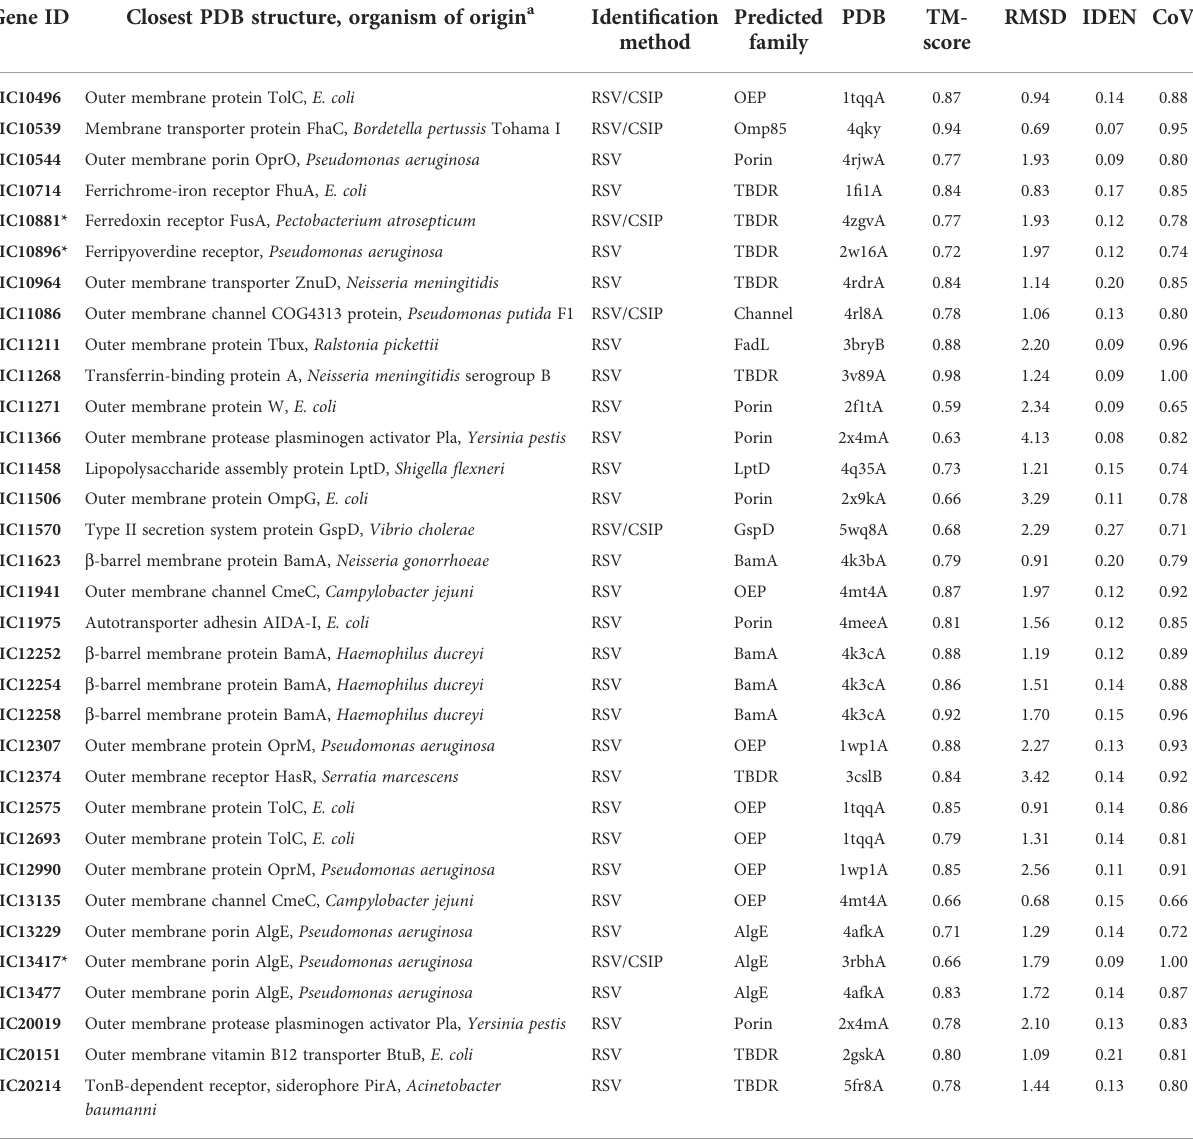
TABLE 1 Closest PDB structures and scores used to predict the 3D models of the b -barrel OMPs. Gene ID Closest PDB structure, organism of origin a Identi fi